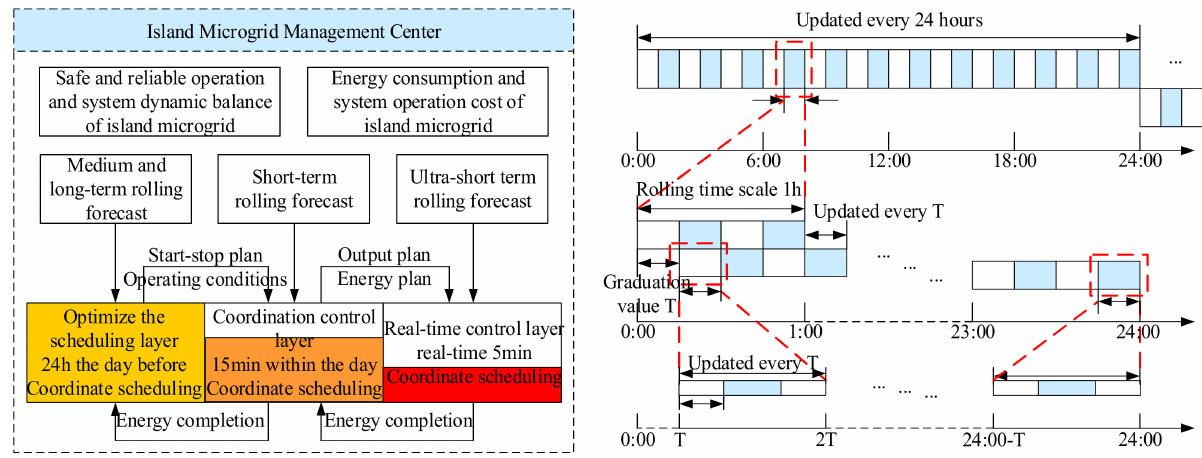
Figure 5. Multiple time scales rolling coordinative dispatching method for island